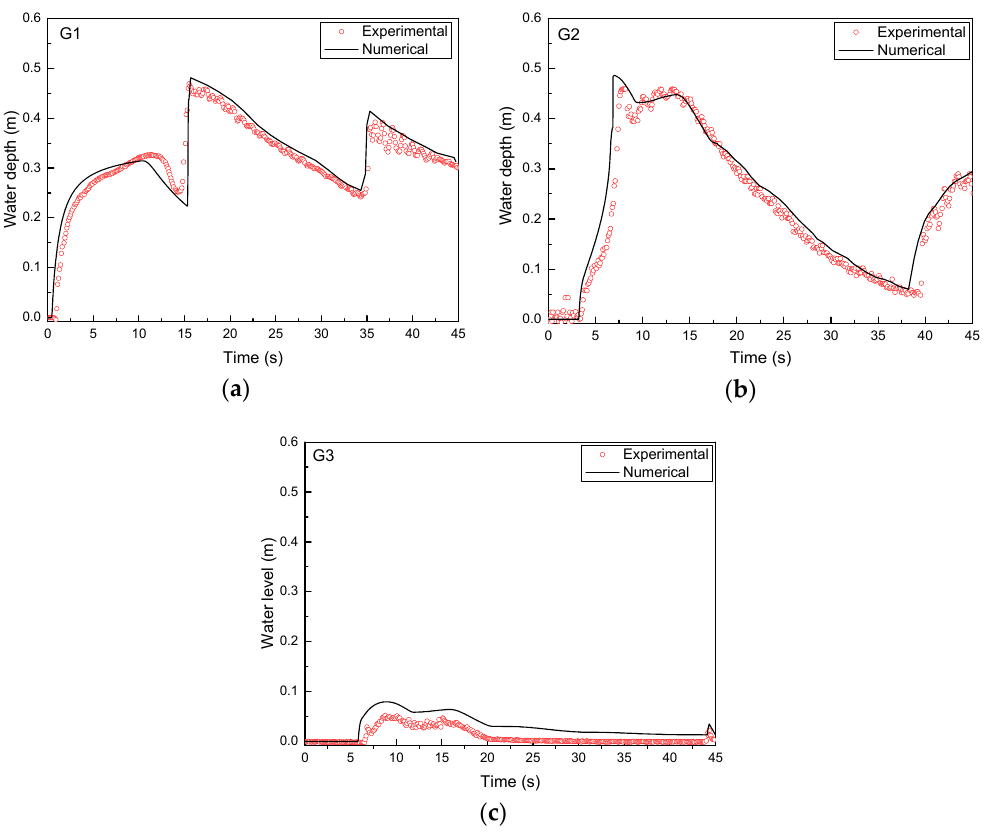
Figure 20. Comparisons of numerical and experimental time histories at different gauges: ( a ) gauge 1 at 17.5 m; ( b ) gauge 2 at 28.5 m; ( c ) gauge 3 at 35.5 m.